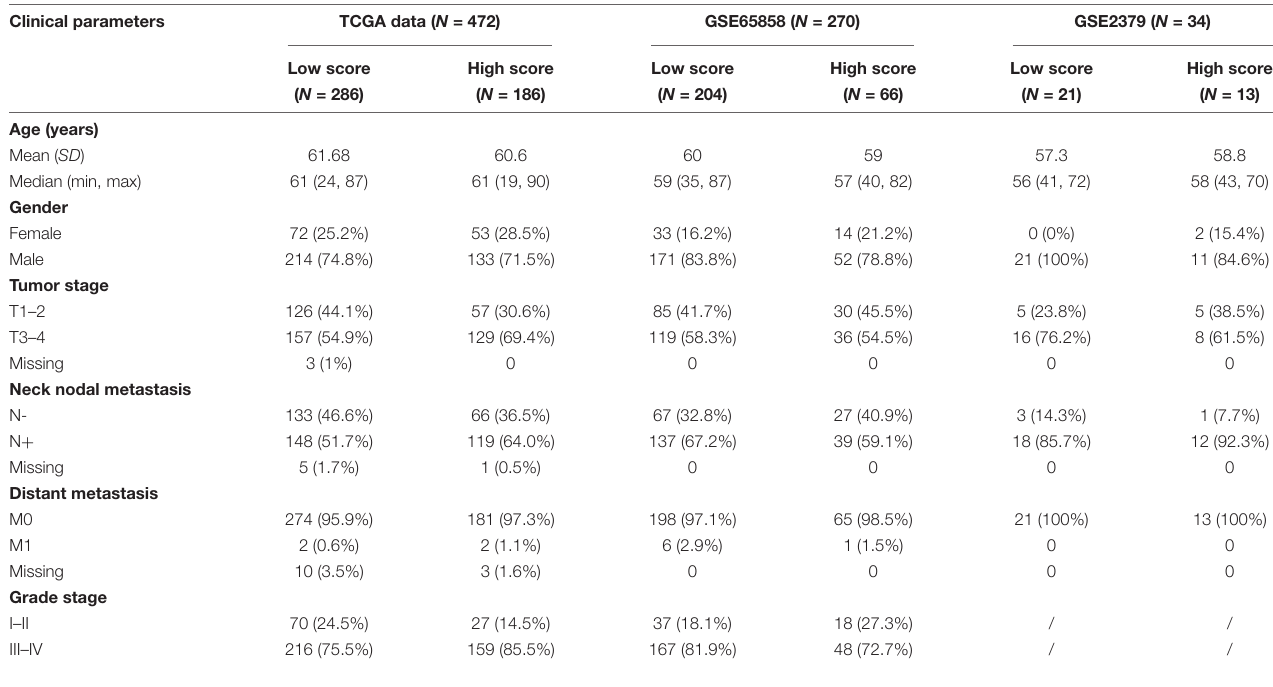
TABLE 1 | Clinical parameters and IRGPs score in HNSCC cohorts. Clinical